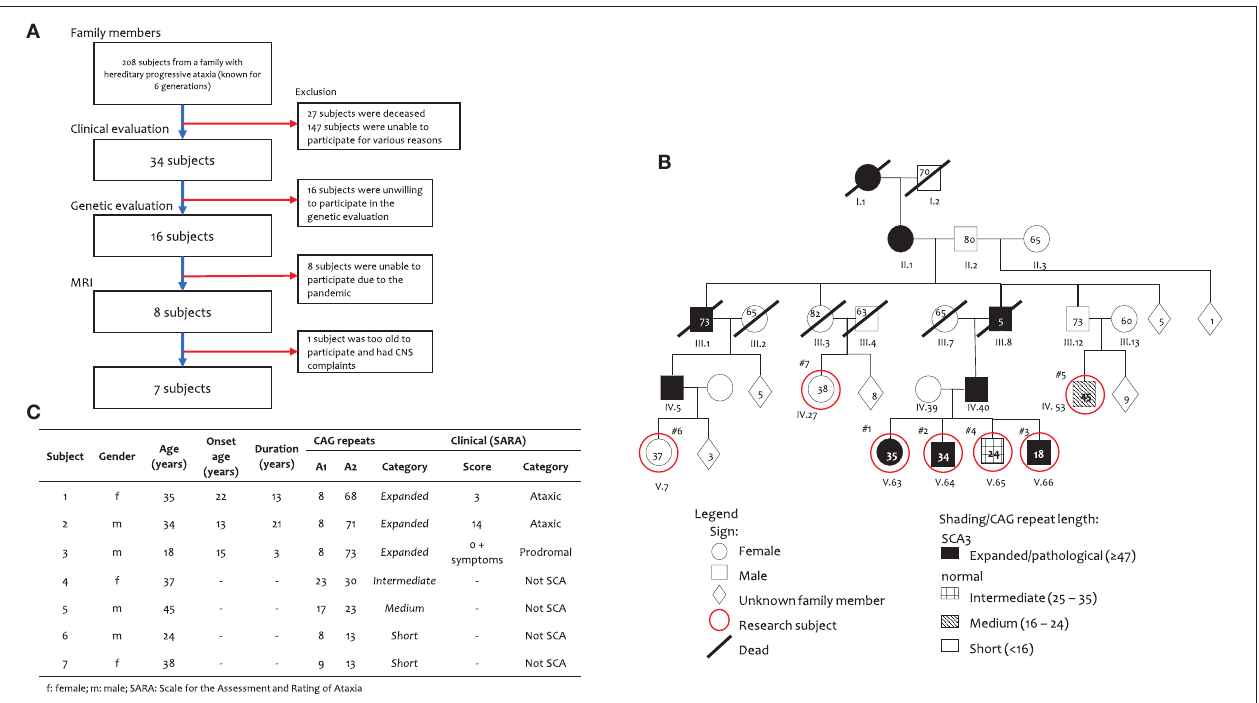
FIGURE 1 | Subject of this study. (A) Subject inclusion, (B) Family pedigree, and (C) Subject characteristics.